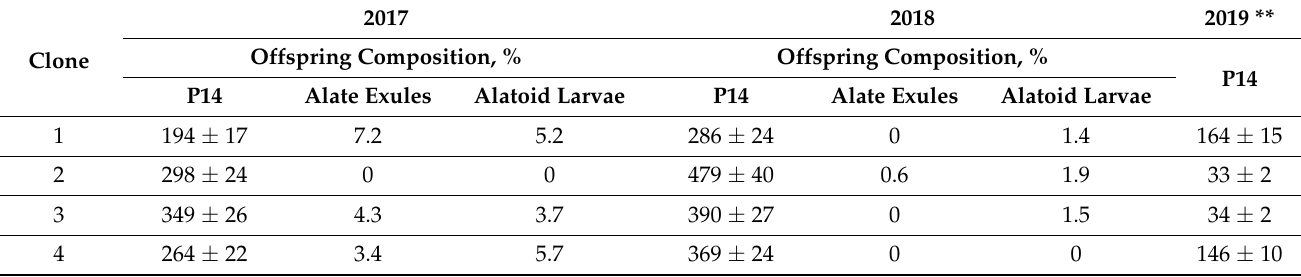
Table 6. The number and composition of apterous exules offspring of Metopolophium dirhodum (Walk.) clones in July 2017–2019